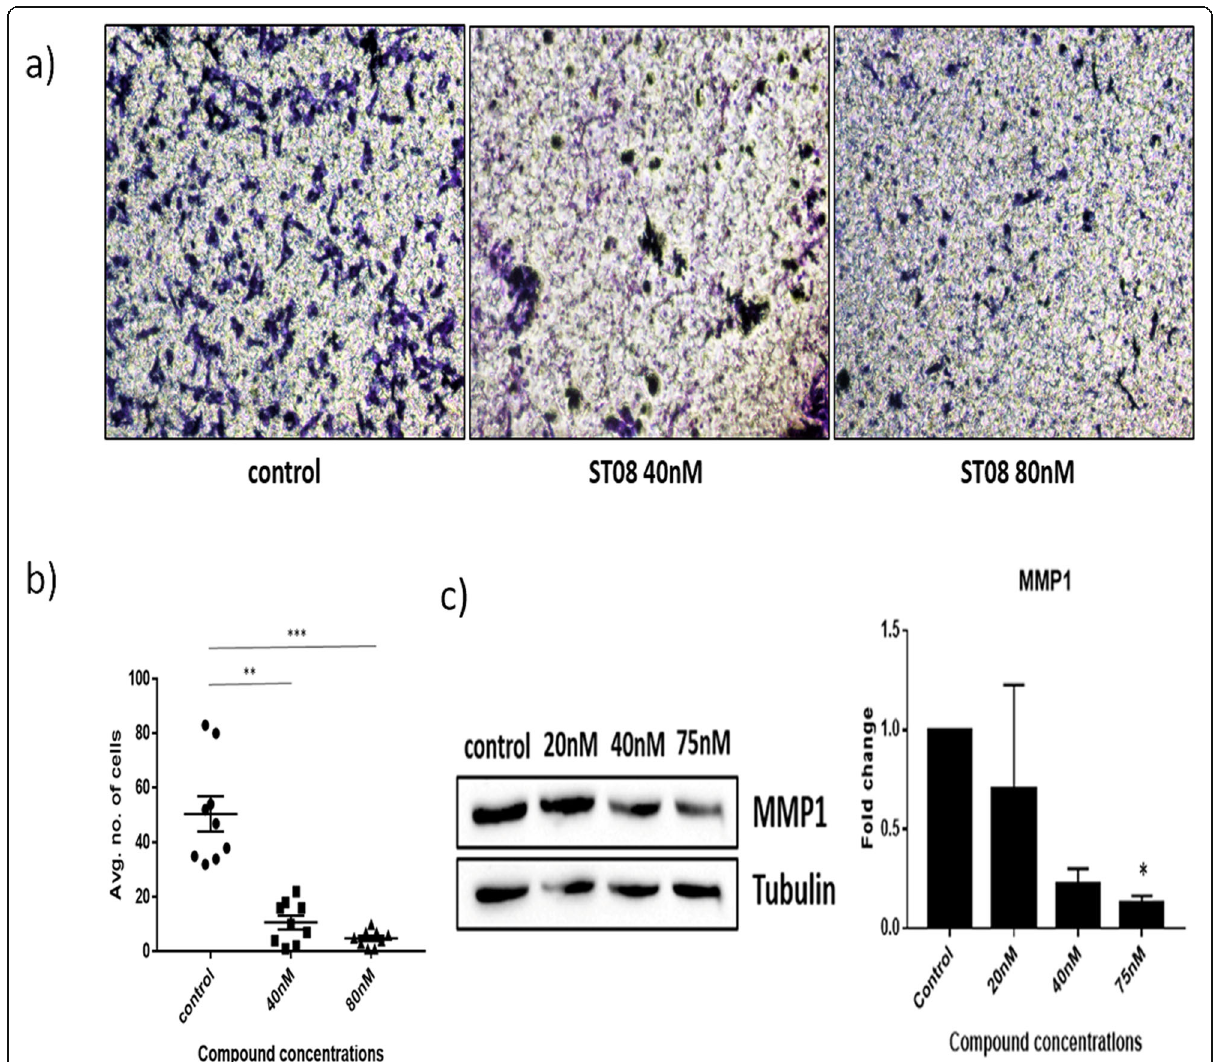
Fig. 7 Effect of ST08 on MDA-MB-231 cell migration a ST08 treated MDA-MB-231 migration in vitro and b its quantification c) Expression of MMP1 in ST08 treated MDA-MB-231 cells . Each experiment was repeated for a minimum of 3 times and plotted as bar graphs with error bars. One-way ANOVA was conducted and the p value was calculated between control and ST03 treated groups, where, *: p value < 0.05, **: p value < 0.005 *: p value < 0.05, **: p value < 0.005, ***: p value < 0.0001, ****: p value <